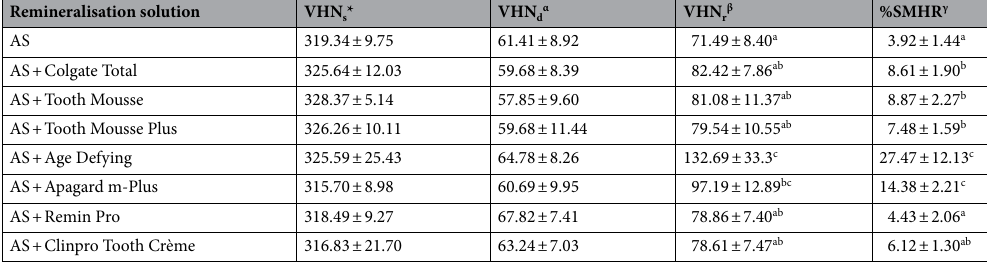
Table 3. Surface microhardness recovery of subsurface enamel lesions by treatment solutions. *VHN s : Kruskal–Wallis test—no difference across treatments (p > 0.05). α VHN d : ANOVA—no difference across treatments (p > 0.05). β VHN r : ANOVA—significant difference across treatments (p < 0.0001). γ %SMHR: ANCOVA—main effects model for treatment and VHN s –VHN d as covariate. Significant differences across treatments (p < 0.0001) with significant effect of VHN s –VHN d as covariate (p = 0.042). abc Same superscripts in column denote means that are not significantly different (p > 0.05). All differences between treatments were measured using pairwise comparisons with a Sidak adjustment.